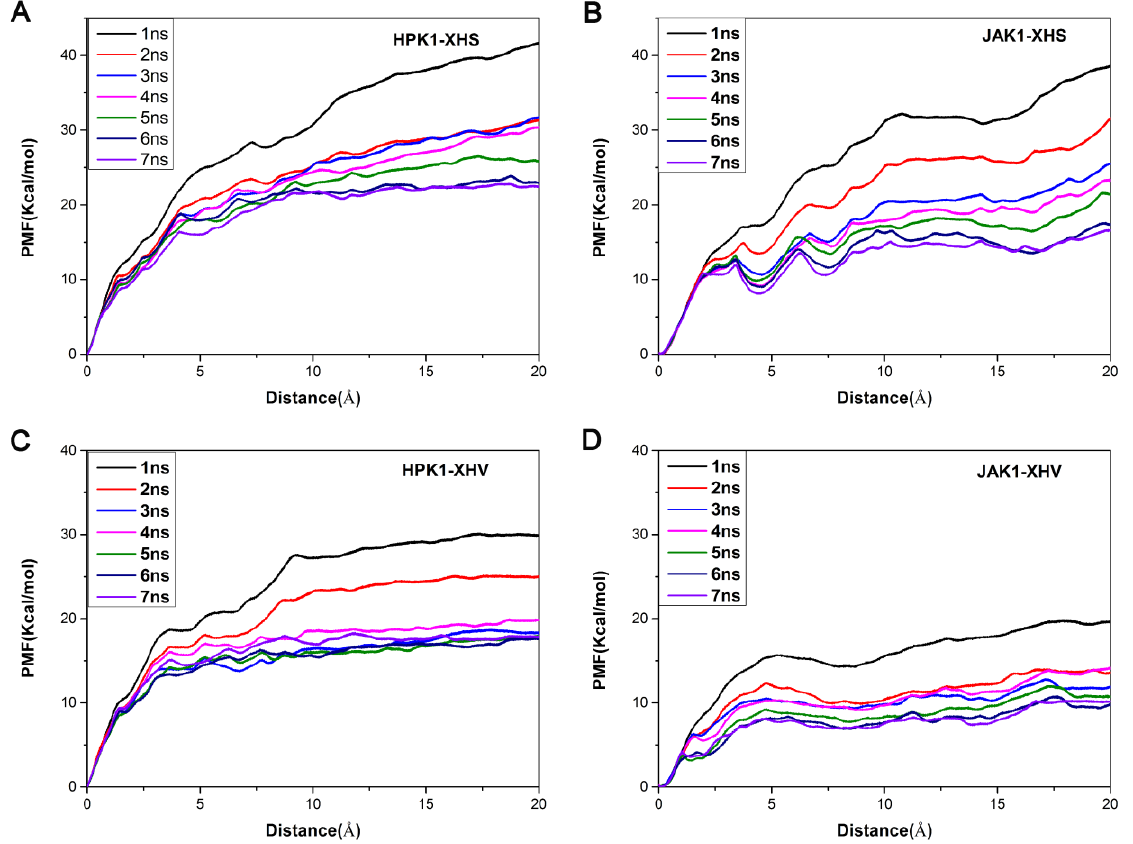
Figure 6. Convergence of the PMFs calculated for four systems by umbrella sampling simulations. ( A ) HPK1-XHS system, ( B ) JAK1-XHS system, ( C ) HPK1-XHV system, ( D ) JAK1-XHV Table 4. PMFs of the inhibitor unbinding from the ATP pocket based on the US simulations. Energy HPK1-XHS